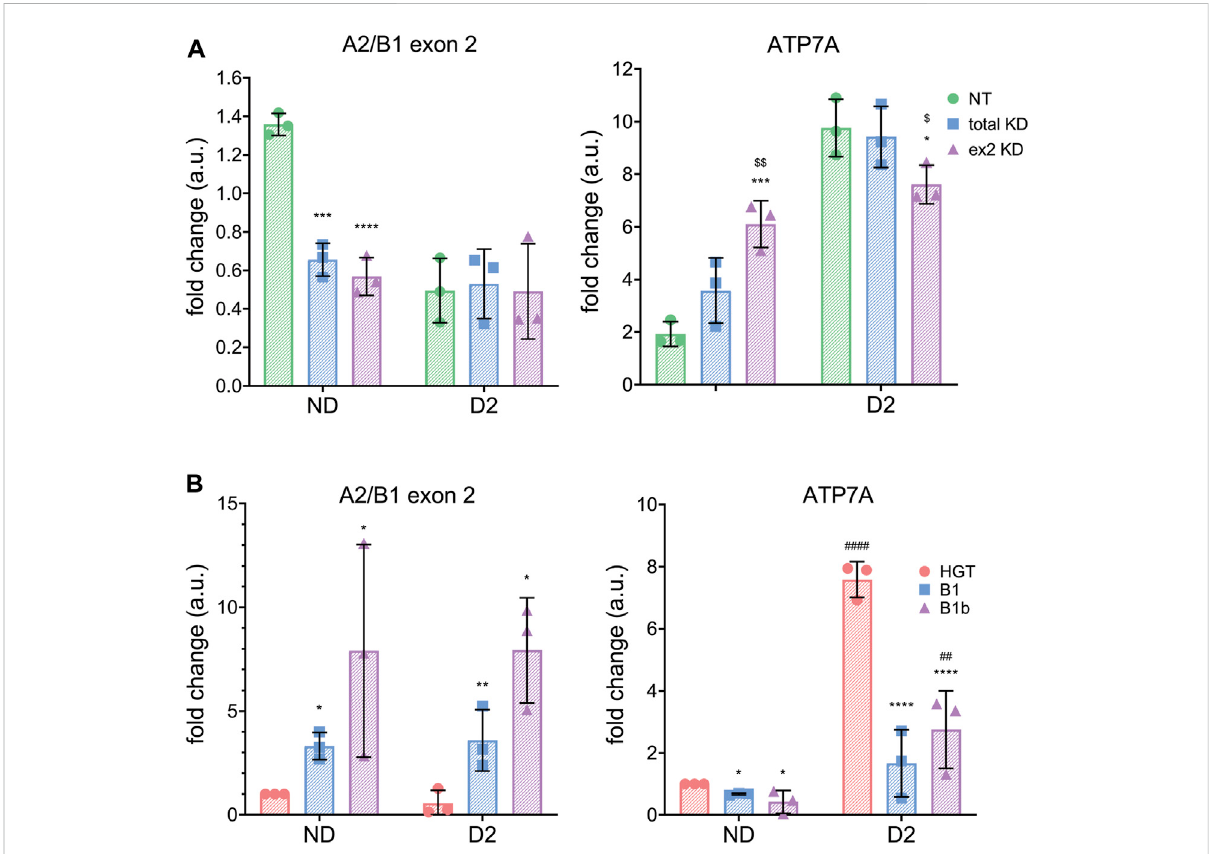
FIGURE 6 hnRNPA2/B1 regulates ATP7A expressionin SH-SY5Y cells. SH-SY5Y cells were transfectedwith non-targeting (NT,green) siRNA, siRNA against all 4 isoforms of hnRNPA2/B1 (total KD, blue), or siRNA against the exon 2-containing B-isoforms of hnRNPA2/B1 (ex2 KD, purple). After 24 h of incubation, differentiation was induced by adding RA to the media. After 48 h, cells were collected for analysis. (A) qRT-PCR analysis of mRNA abundance of hnRNPA2/B1 isoforms and ATP7A . Values normalized to hS18 and ND controls, n = 3. (B) ATP7A mRNA abundance decreases uponoverexpressionofexon2-containingB-isoforms(green-emptyplasmid, blueisoformB1andpurple-isoformB1b).qRT-PCRanalysisofmRNA abundance of hnRNPA2/B1 isoforms and ATP7A in non-differentiating and differentiating SH-SY5Y cells . Signi fi cance was determined by two-way ANOVA; * p < 0.05, ** p < 0.01, *** p < 0.001, **** p < 0.0001 compared to NT and $ p < 0.05, $$ p < 0.01, $$$ p < 0.001 compared to total